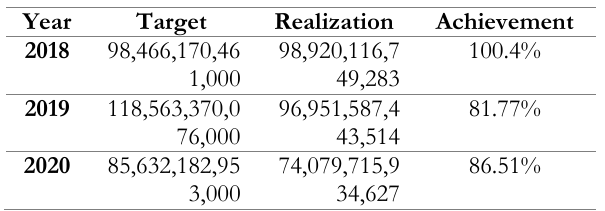
Table 4 Target and Realization of Tax Revenues LTO